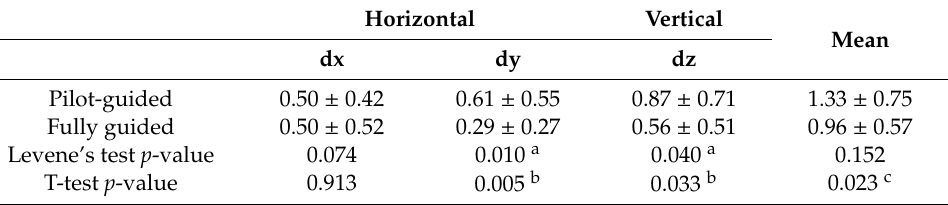
Figure 9. Box plots for angulation deviations. (Circle and asterisk representing outlier(values that do not fall in the whisker bars) and extreme outlier(values more than three times the height of the boxes), respectively.). Table 2. Deviations—shoulder area.